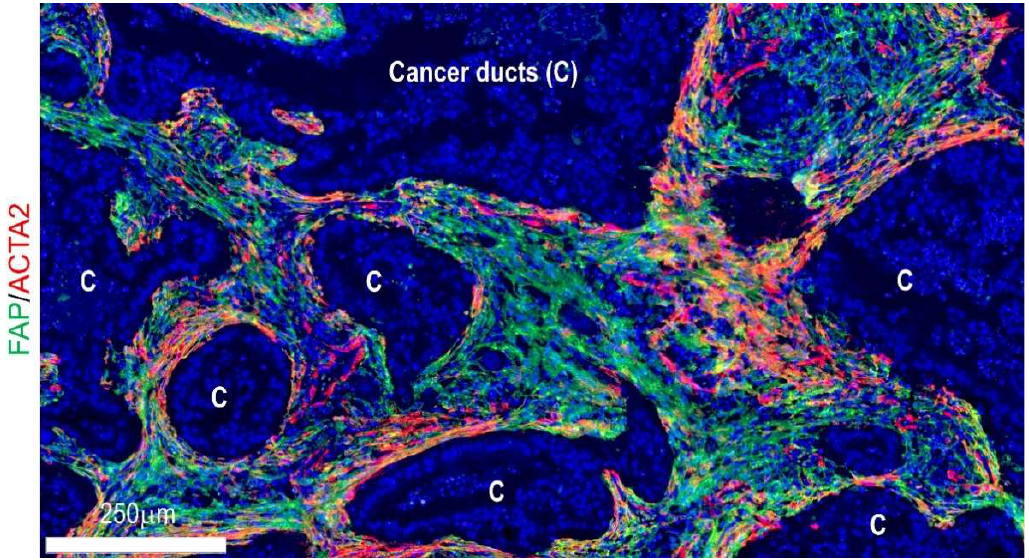
Figure 2. Visualization of fibroblast subpopulations in human pancreatic cancer tissues using fluo- rescent immunohistochemistry for ACTA2 and FAP. cent immunohistochemistry for ACTA2 and